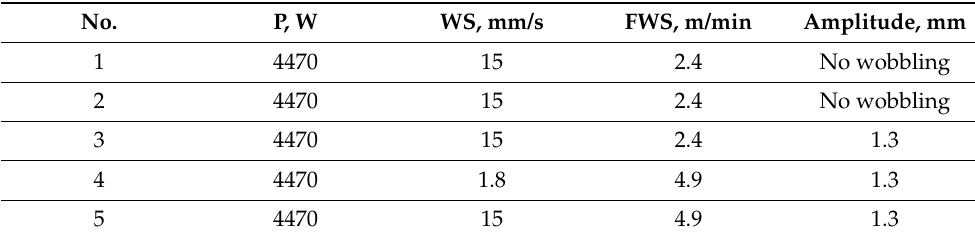
Table 3. Variable laser cladding